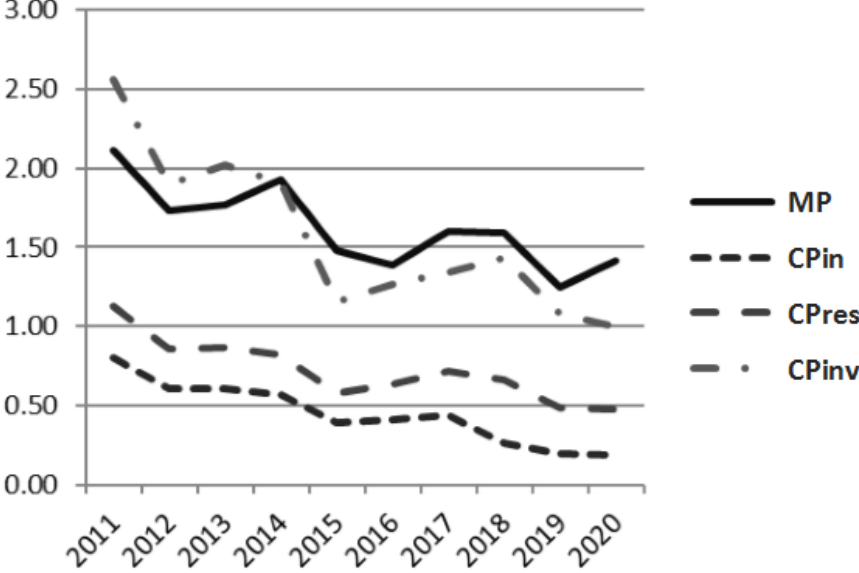
Figure 6. Material and capital productivity value dynamics for Freeport-McMoRan Inc. (Phoenix, AZ, USA) MP—material productivity; CPinv—indicator calculated based on initial CP values of machinery and equipment.